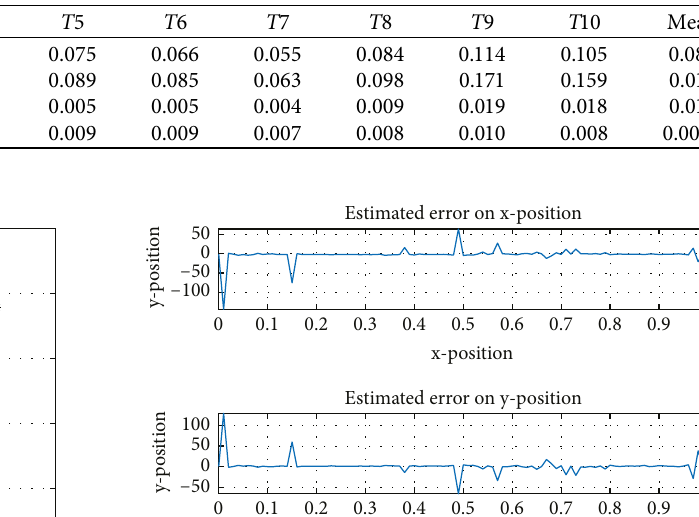
Table 2: The mean of the trials for the EKF (one landmark and Gaussian noise).